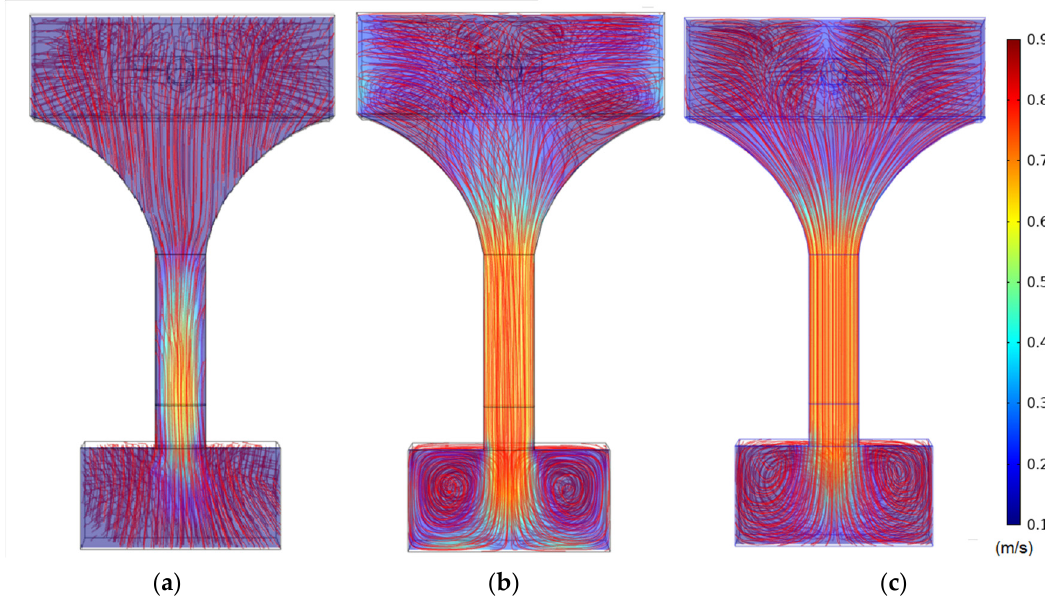
Figure 8. Streamlines in the observation chamber and the diffusion chamber as well as in the collecting chamber produced by ( a ) Laminar model, ( b ) Turbulent model with Global Mesh “normal” refinement, and ( c ) Turbulent model with Partial Refinement method. The mean velocity of these models at the inlet is 3 m/s.